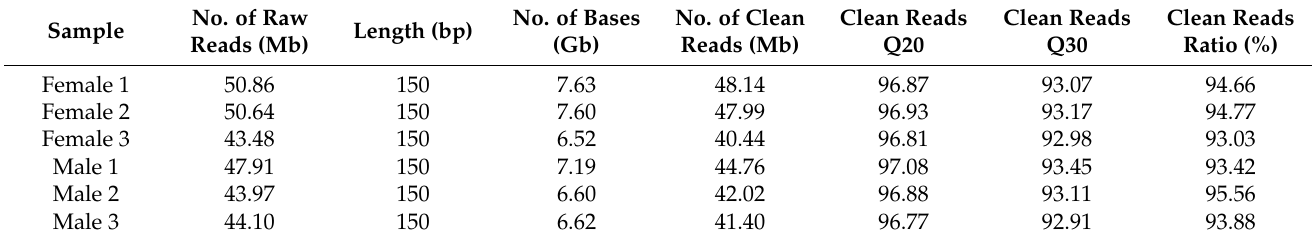
Table 1. Statistics for sequencing raw reads and clean